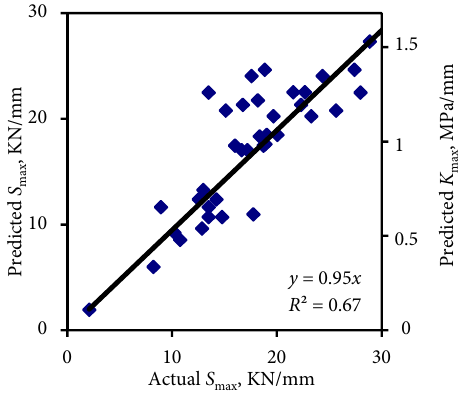
Fig. 6. Prediction of S max for independent query test dataset